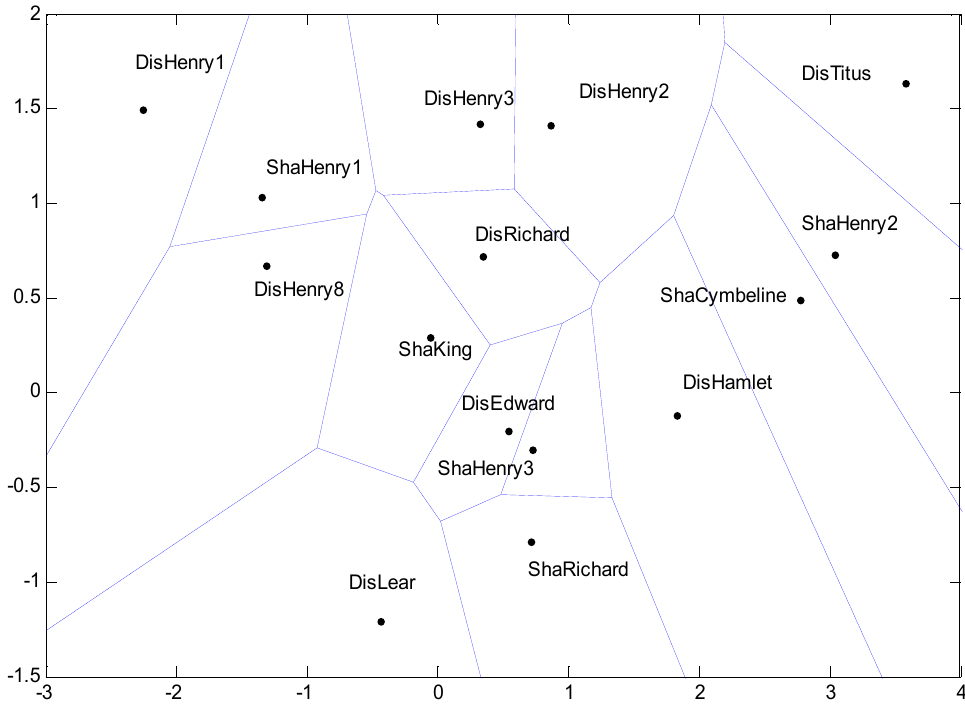
Figure 9. Voronoi map of Shakespeare D FW